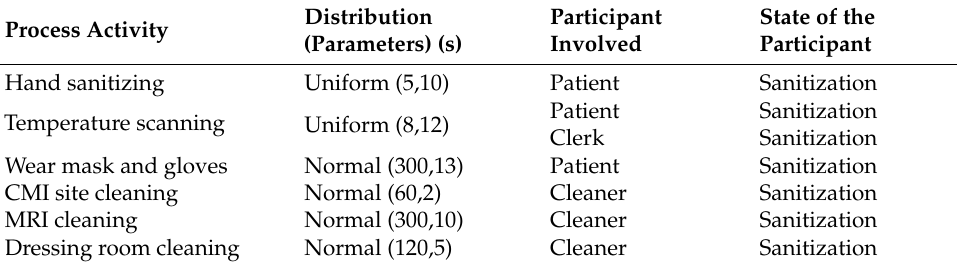
Table 3. Time distribution of the key additional process activities—COVID-19